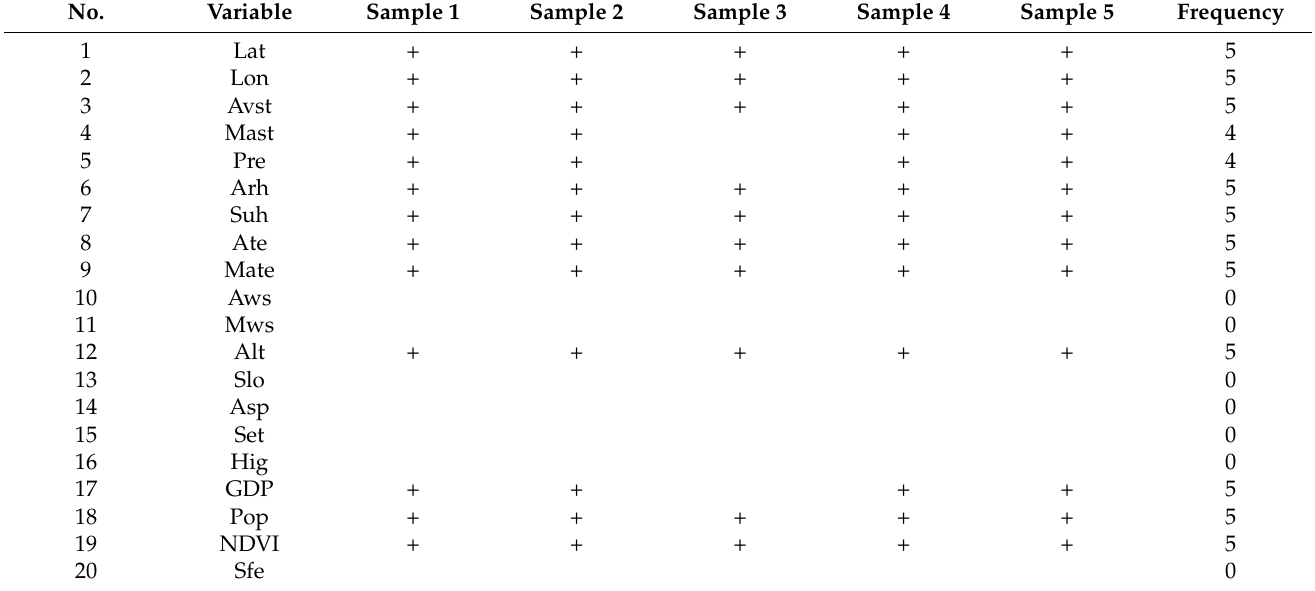
Table 4. Results of variable selection based on RF.